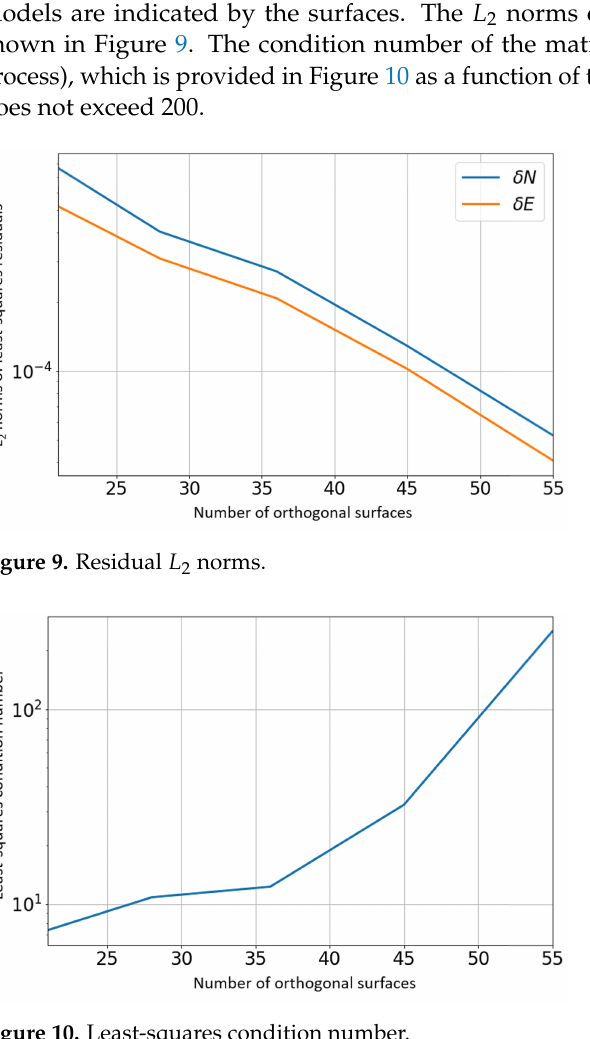
Figure 10. Least-squares condition